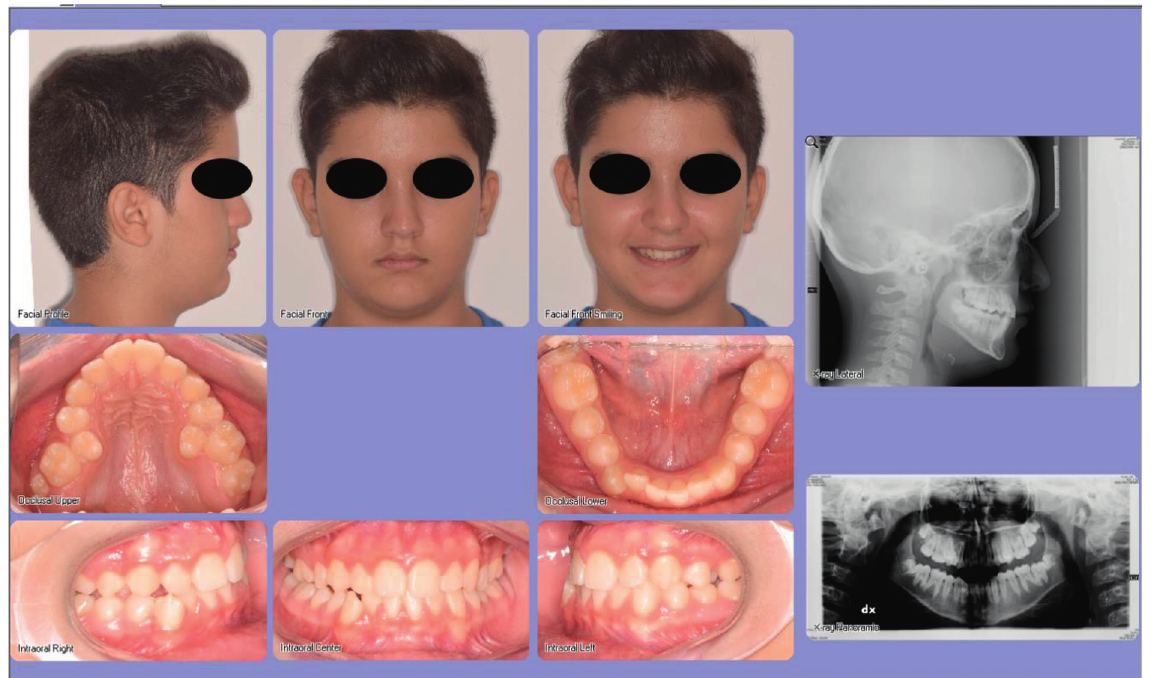
Figure 1: Example of conventional digital diagnostic records formatted in orthodontic software. Clinicians usually make decisions and plan treatment strategies in front of a monitor, taking the time needed to evaluate the patient’s characteristics (skeletal, soft-tissue, and dento- alveolar components). These files can also be shared for a multidisciplinary approach.